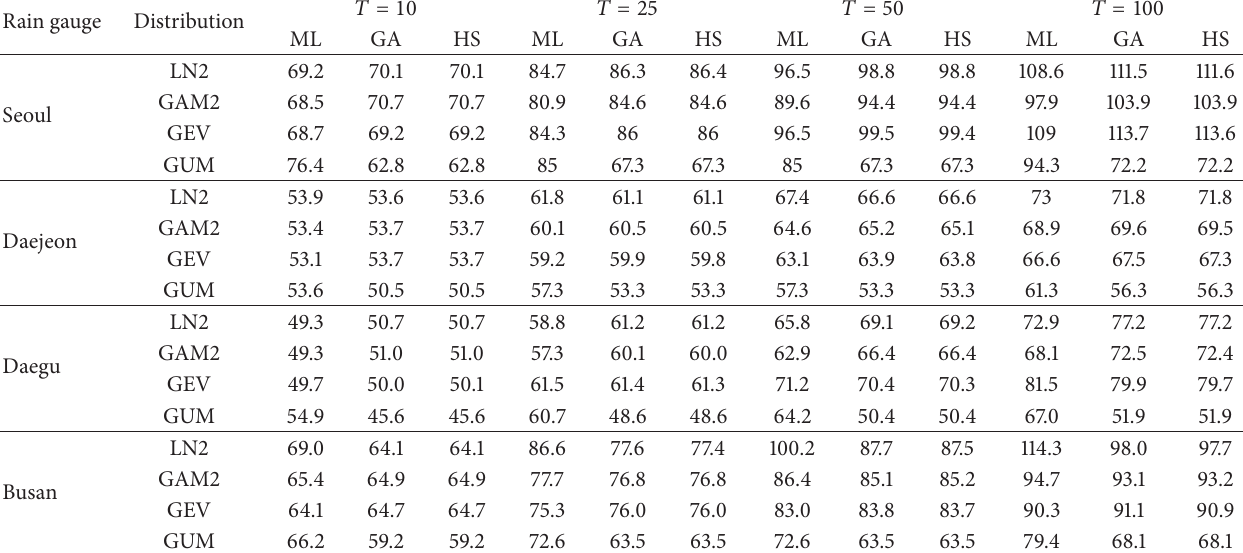
Table 6: Quantiles for different return periods ( 𝑇 = 10 , 25, 50, and 100years) of the four major cities in Republic of Korea. Rain